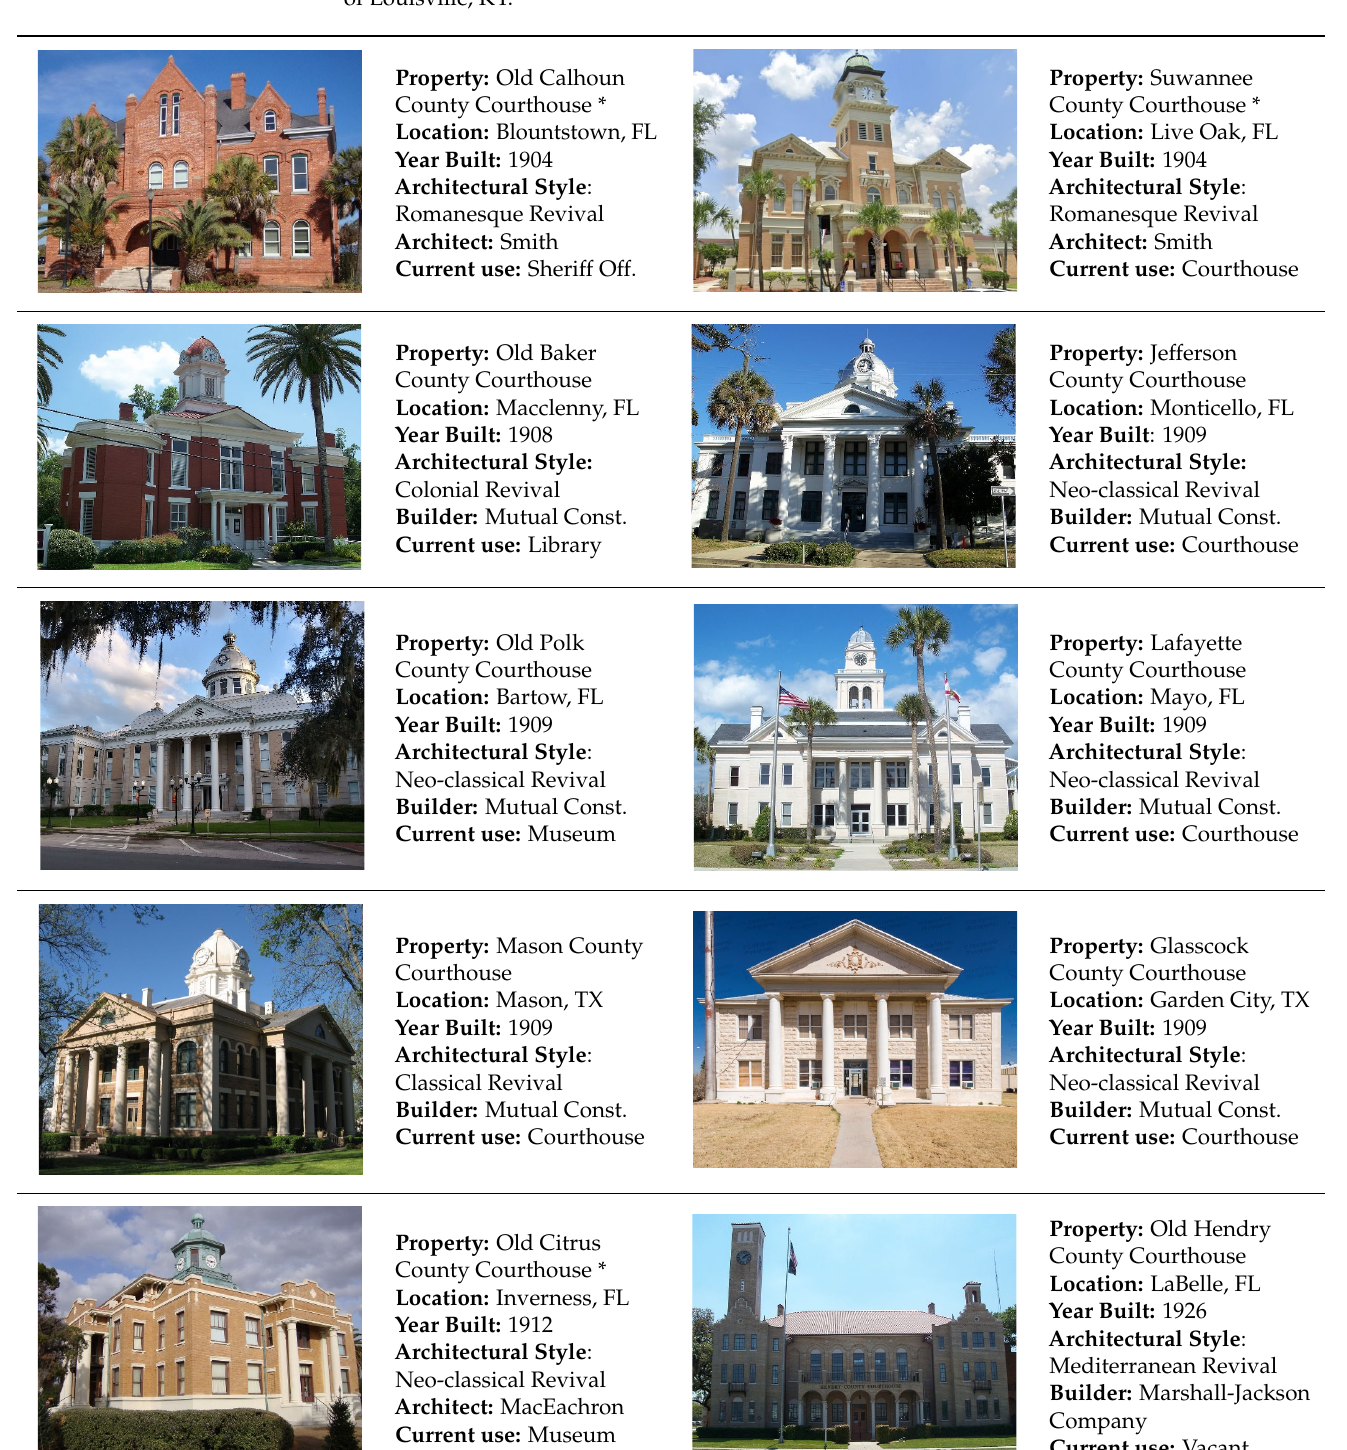
Table 1. The ten historic courthouses selected for review. Seven of the courthouses were designed by E.C. Hosford between 1908–1926. Six of the courthouses were built by Mutual Construction Company of Louisville, KY.